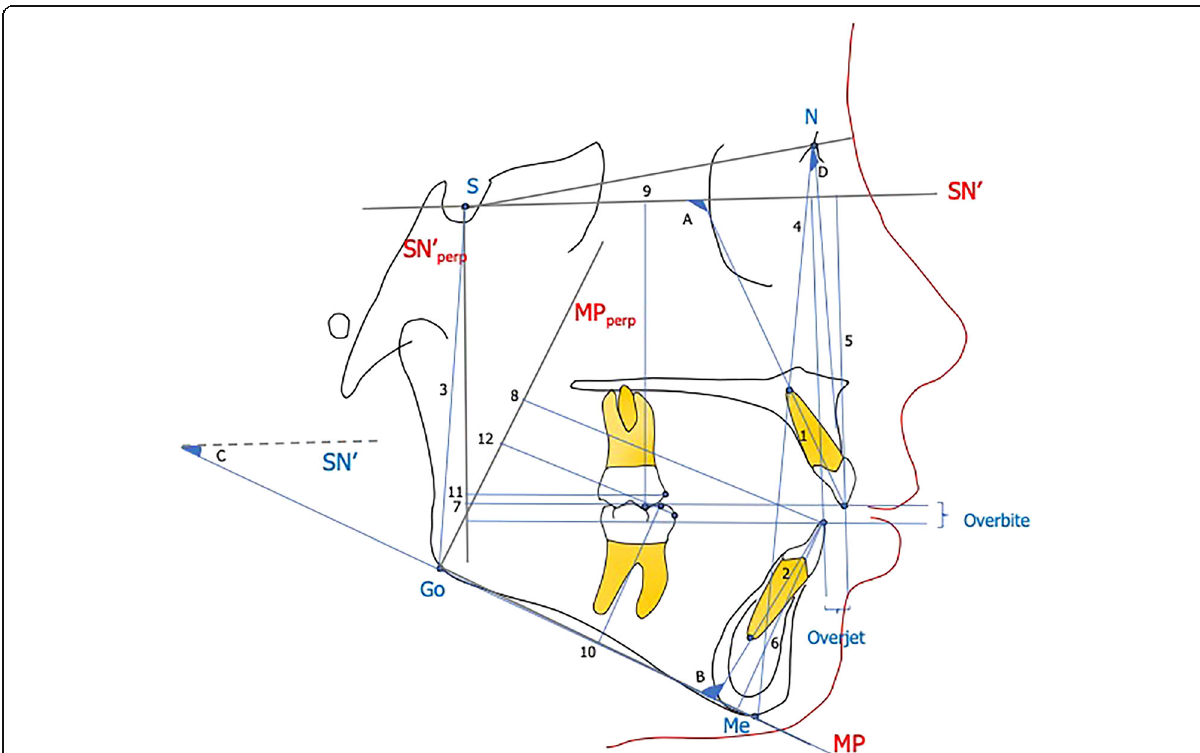
Fig. 1. Angular measurements (°). A, U1-SN ′ : angle between SN ′ and long axis of upper incisor; B, IMPA: angle between Go-Me and long axis of lower incisor; C, SN ′ -MP: angle between SN ′ and MP (Go-Me); D, ANB: angle between N-A and N-B. Linear measurements (mm) . 1, UI length: distance from upper incisor tip to apex; 2, LI length: distance from lower incisor tip to apex; 3, PFH: shortest distance from S-Go; 4, AFH: shortest distance from N-Me; 5, U1-SN ′ : distance from tip of upper incisor to SN ′ ; 6, L1-MP: distance from lower incisor tip to MP; 7, U1-SN ′ perp : distance from tip of upper incisor to SN ′ perp ; 8, L1-MP perp : distance from lower incisor tip to MP perp; 9, U6-SN ′ : distance from upper molar MB cusp to SN ′ ; 10, L6-MP: distance from lower molar MB cusp to MP ; 11, U6-SN ′ perp : distance from tip of upper molar MB cusp to SN ′ perp ; 12, L6-MP perp : distance from lower molar MB cusp to MP perp ; overbite: distance from tip of U1 to tip of L1 perpendicular to SN ′ perp ; overjet: distance from tip of U1 to tip of L1 perpendicular to SN